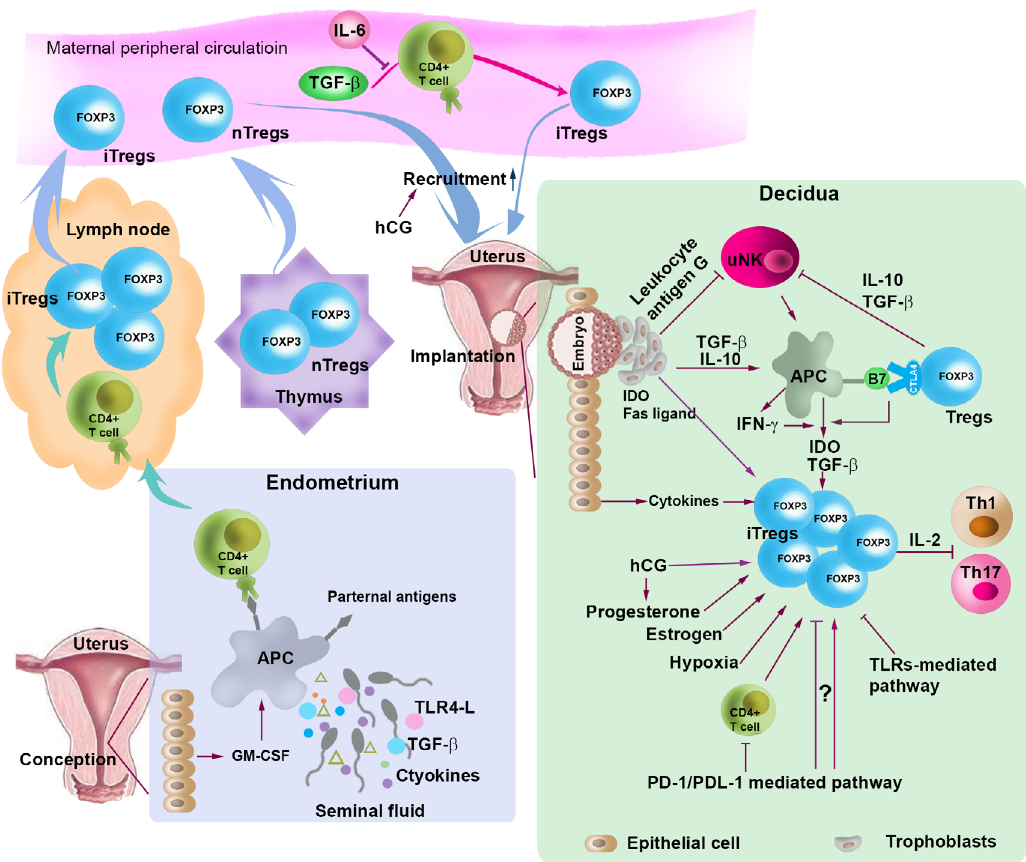
Figure 1. Regulation of the generation, expansion and recruitment to the uterine of Tregs. At conception, TGF-β, toll-like receptor (TLR) 4 ligand (TLR4-L), paternal antigens, and cytokines in seminal fluid and granulocyte-macrophage colony-stimulating factor (GM-CSF) released by uterine epithelial cells stimulate antigen-presenting cells (APCs), which carry paternal antigens, traffic to the lymph node and present the antigens to naive T cells, thereby activating naive T cells. Activated naive T cells proliferate and differentiate into Tregs. During implantation, expanded Tregs from the lymph node and the thymus are recruited into the uterus. Treg generation, expansion and recruitment are regulated by cytokines (e.g., TGF-β and IL-10) hormones [e.g., estrogen, progesterone and human chorionic gonadotropin (hCG)], indoleamine 2,3-doxygenase (IDO), Fas ligand, hypoxic microenvironment, programmed death 1 (PD-1)/PD-ligand 1 (PDL-1) and TLRs-mediated pathways. Tregs inactivate T helper 1 (Th1) and Th17 by sequestering IL-2 and inhibit uterine NK (uNK) cells through TGF-β and IL-10. Treg generation and expansion are also modulated through crosstalk with trophoblasts and uNK cells. nTregs: natural Treg; CTLA4: cytotoxic T-lymphocyte